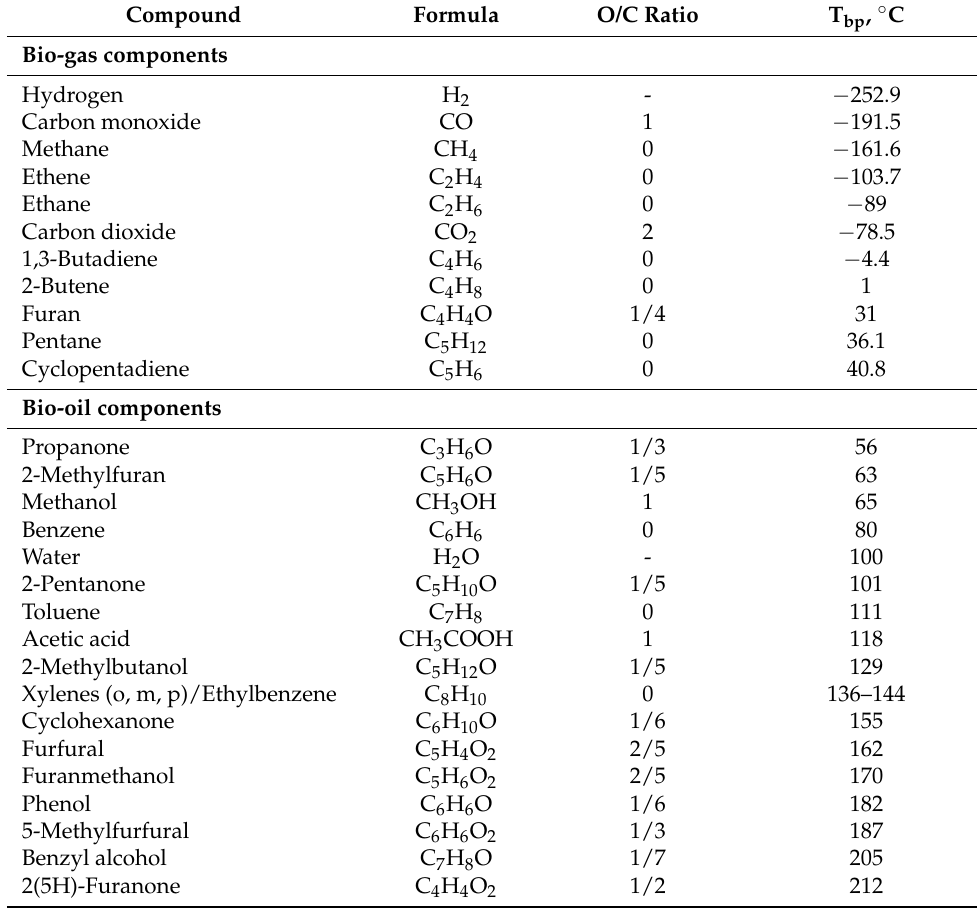
Table 4. Most abundant compounds identified from pyrolysis of Agave salmiana bagasse by ma- ss